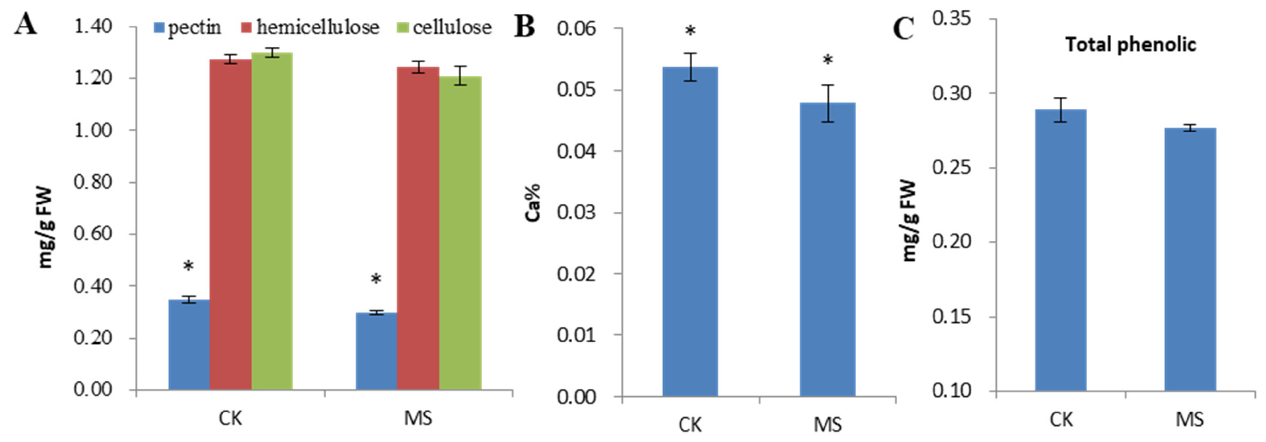
Figure 3. Changes in the physiological indices of CK and MS pineapple flesh. ( A ) Content of cell wall components; ( B ) calcium content; ( C ) total phenolic content. CK: normal fruit; MS: mildly watercored fruit. ANOVA was used to compare the index content between CK and MS; error bar represents the standard deviation of the three replicates. * p < 0.05.